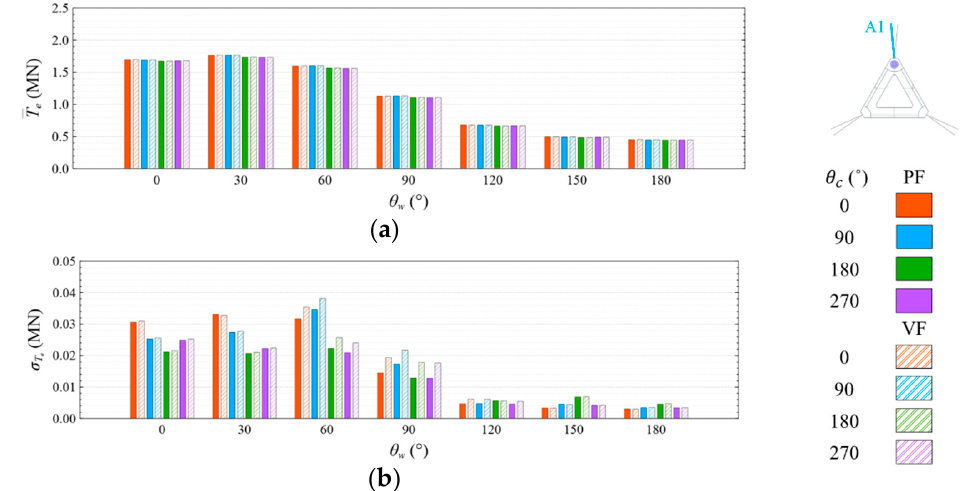
Figure 28. Comparison of ( a ) means and ( b ) standard deviations of mooring line tension of Line A1 under CW condition.